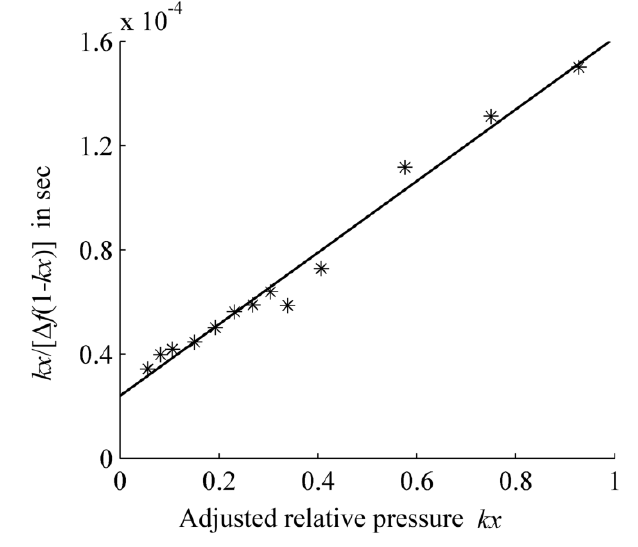
Figure 3. Linear fitting of   1 kx f kx      versus adjusted relative pressure kx at the SAW detector temperature of 25 °C. Solid line: the fitting line; stars: the measured data.